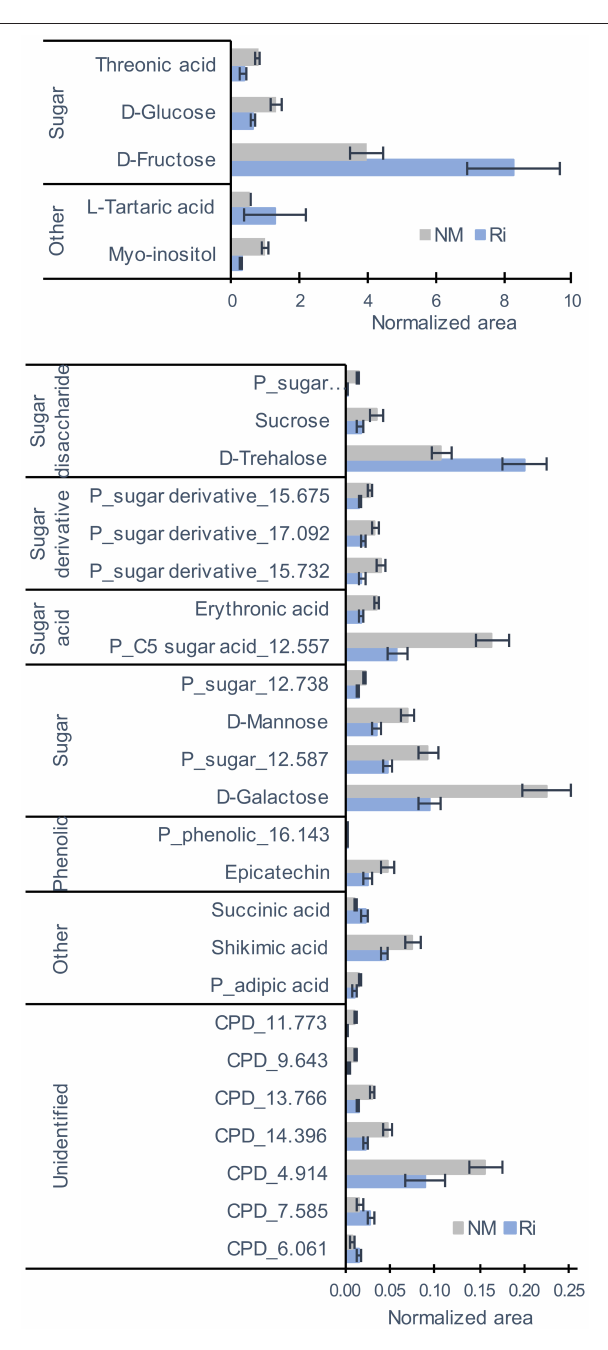
FIGURE 3 | GC-MS metabolites significantly altered by the mycorrhization in roots. Contents are expressed as normalized areas for each metabolite. Data are the mean ± SE of 14 biological replicates for the NM condition and 11 biological replicates for the Ri condition. Metabolites significantly different between NM and Ri conditions were identified with a fold change of at least + /– 1.5 and a p value < 0.05 (Wilcoxon